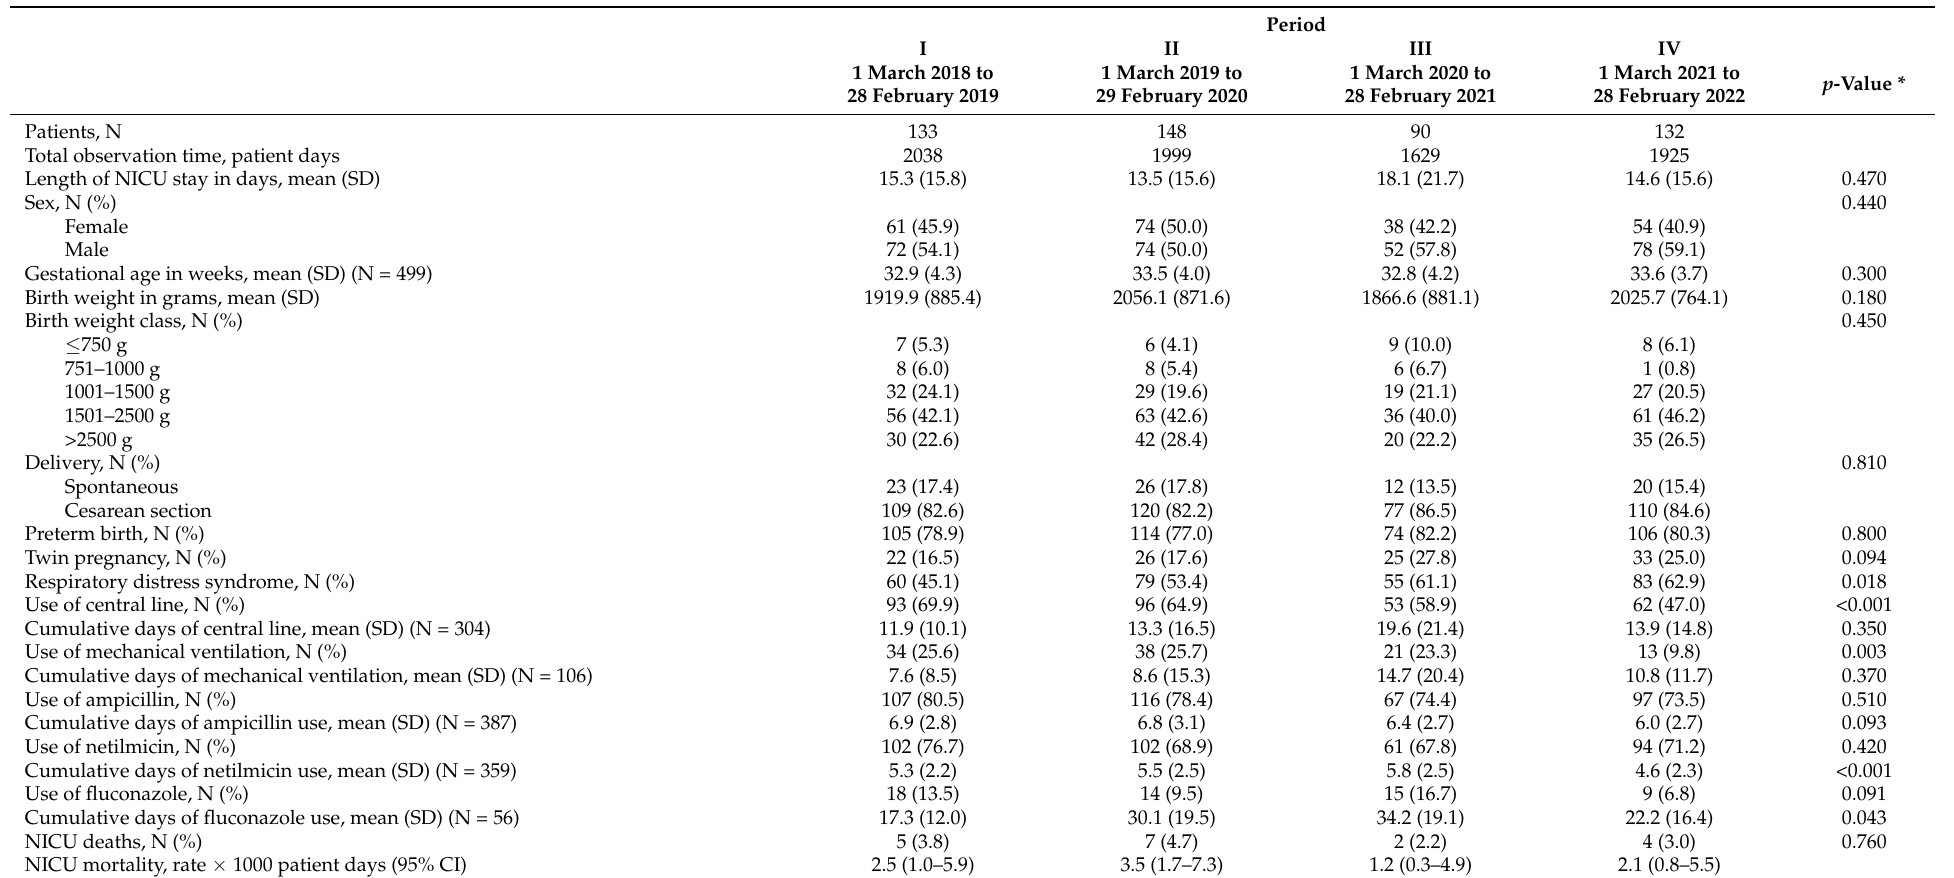
Table 1. Key characteristics of the patients admitted to the neonatal intensive care unit of Umberto I teaching hospital of Rome between March 2018 and February 2022 (N = 503) by study period. Results are expressed as number (percentage, %) or mean (standard deviation, SD). Period I II